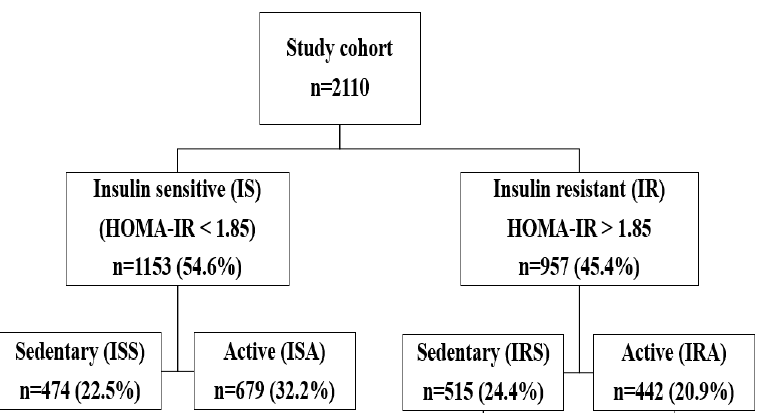
Figure 1. Study design indicating the study groups (ISA, ISS, IRA, and IRS) and their percentages. Table 1. General characteristics of participants.